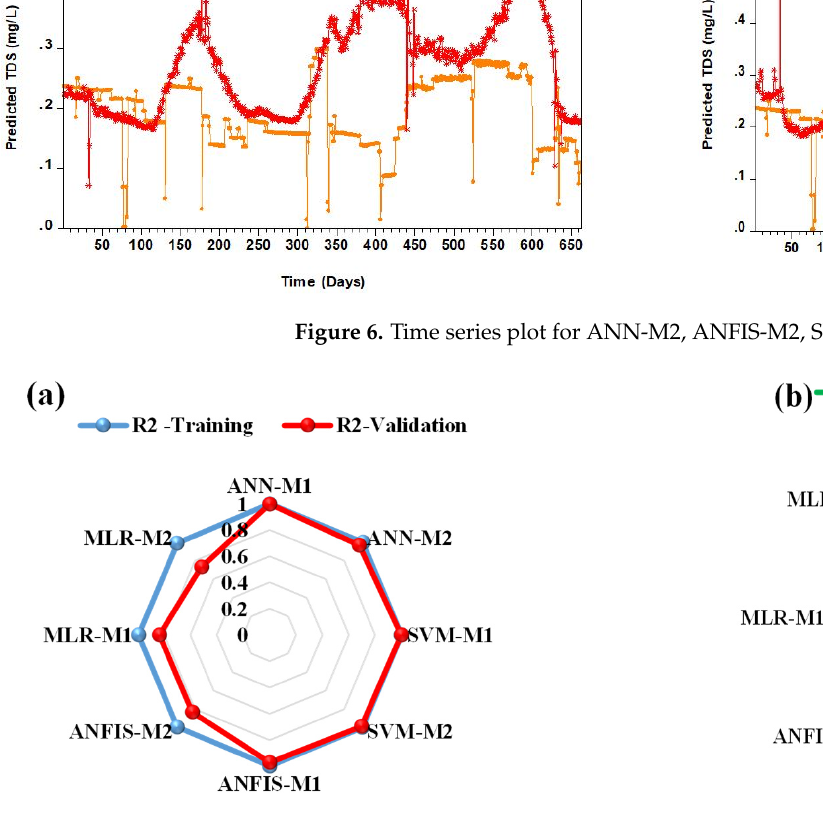
Figure 8. Boxplot for M1 and M2 in the validation phase for TDS. Table 3. Ensemble results of SA-E, WA-E, and NN-E for TDS. Ensemble Techniques